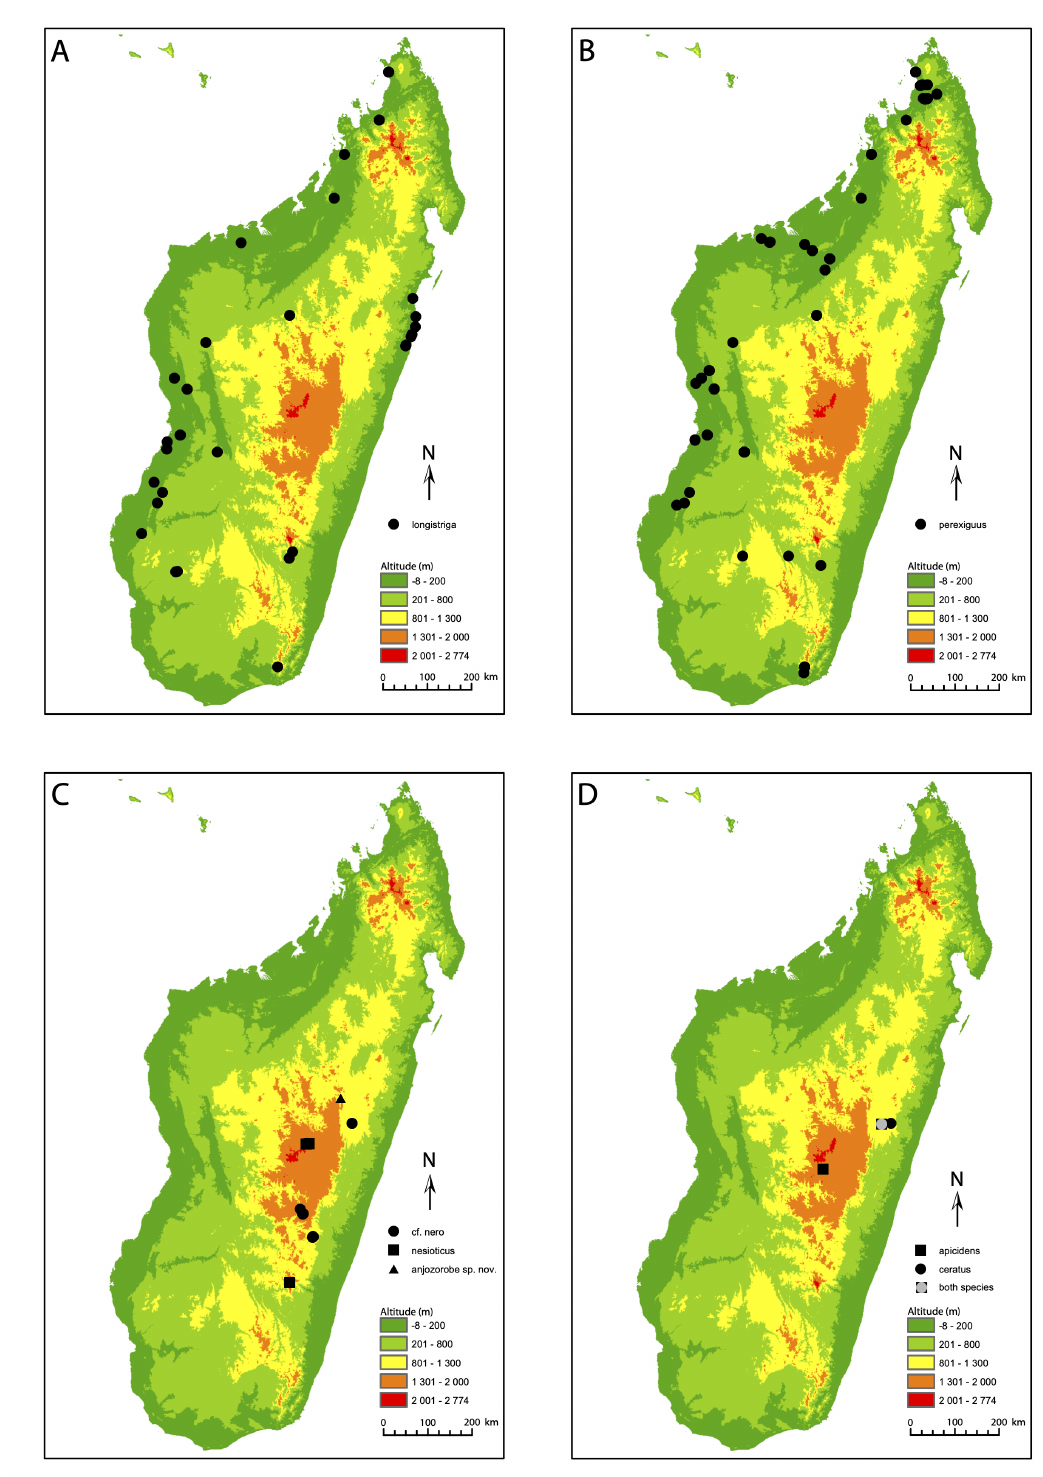
Fig. 4. Distribution maps of the Malagasy species of Bidessus Sharp, 1882. A . B. longistriga Régimbart, 1895. B . B. perexiguus Kolbe, 1883. C . B. cf. nero Gschwendtner, 1933 (circle), B. nesioticus Guignot, 1956 (square), B. anjozorobe sp. nov. (triangle). D . B. apicidens Biström & Sanfilippo, 1986 (square), B. cf. ceratus Guignot, 1941